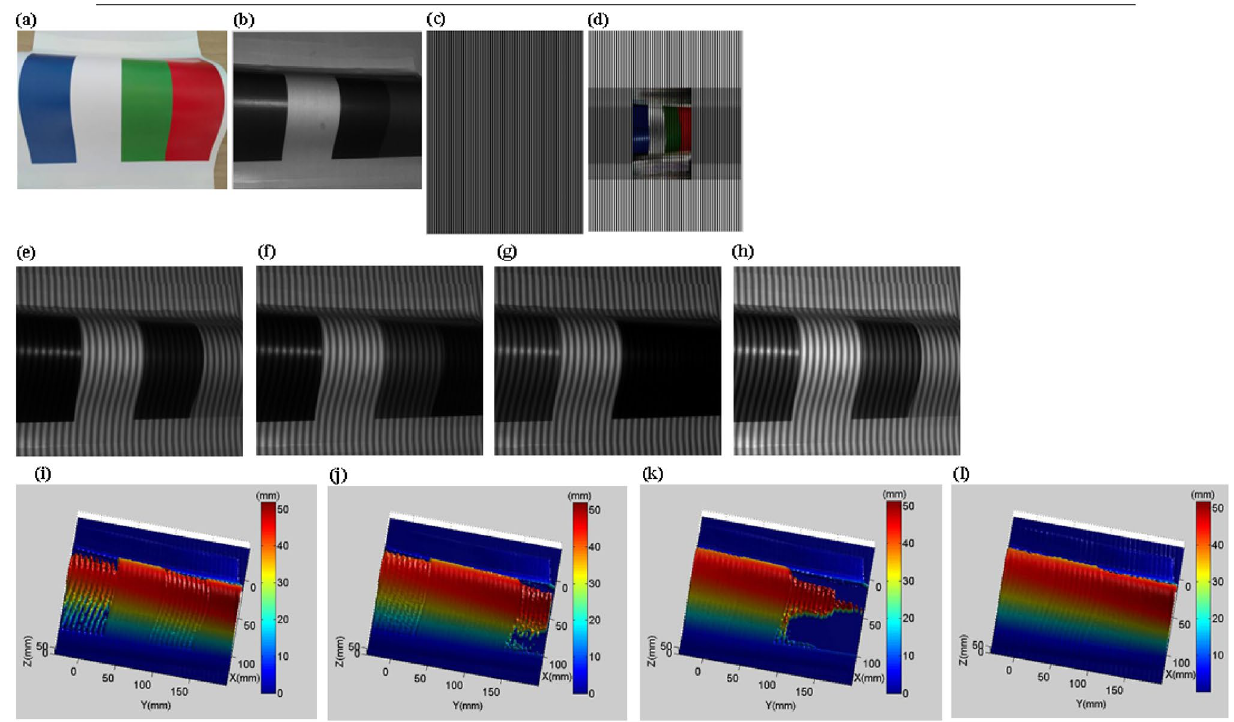
Figure 10. 3-D shape reconstruction of a colorful object 1. ( a ) A colorful object. ( b ) A captured image without fringe projection. ( c ) Original projection fringe pattern. ( d ) Optimized projection fringe pattern. ( e ) A captured fringe pattern during red light projection. ( f ) A captured fringe pattern during green light projection. ( g ) A captured fringe pattern during blue light projection. ( h ) Optimized captured fringe pattern using the method proposed in this paper. ( i ) Reconstructed 3-D surface shape during red light projection. ( j ) Reconstructed 3-D surface shape during green light projection. ( k ) Reconstructed 3-D surface shape during blue light projection. ( l ) Reconstructed 3-D surface shape using the method proposed in this